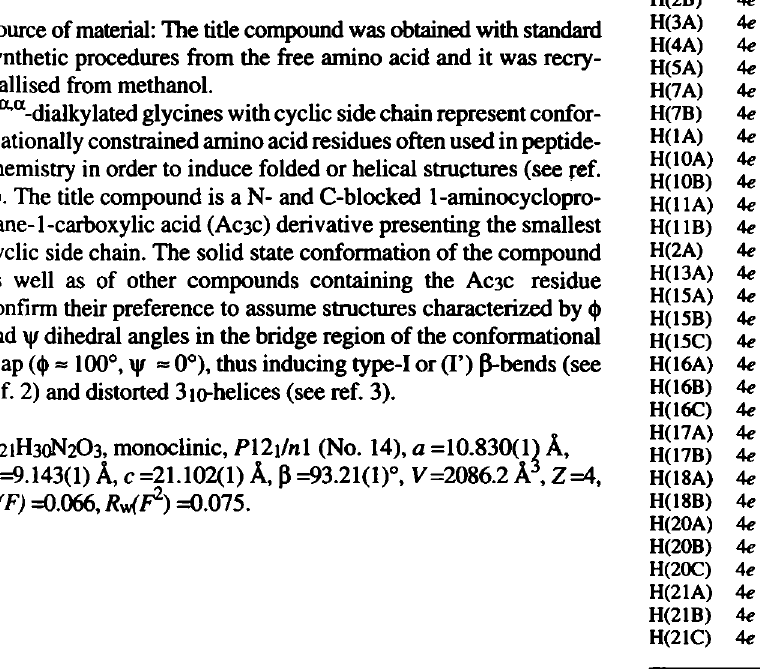
Table 2. Final atomic coordinates and displacement parameters (in